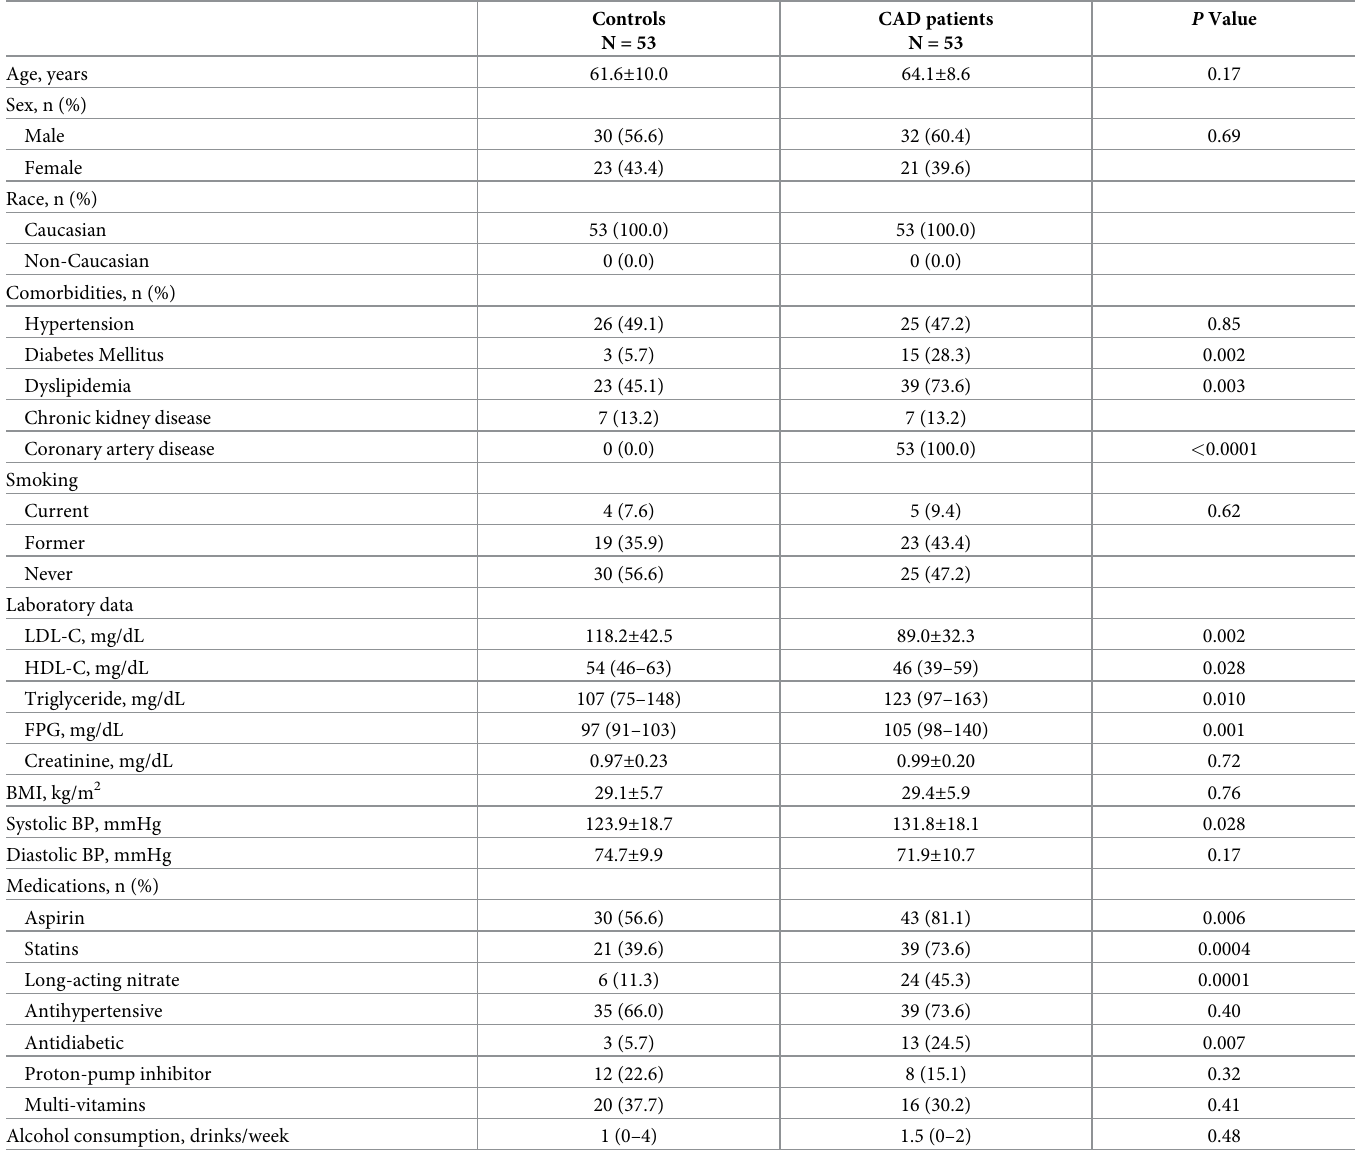
Table 1. Baseline